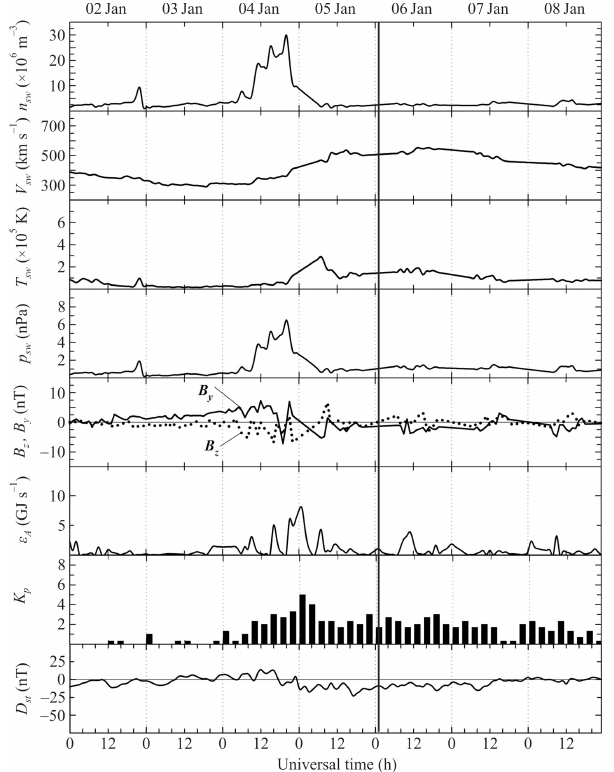
Figure 1. Universal time dependencies of the solar wind parame- ters: observed proton number density ( n sw ), plasma speed ( V sw ), and temperature ( T sw ); calculated dynamic pressure ( p sw ); mea- sured components of the interplanetary magnetic field ( B z and B y ); estimated energy input ( ε A ) into the Earth’s magnetosphere from the solar wind per unit time; and Kp- and Dst-indices for the 2– 8 January 2019 period. Dates are shown along the upper abscissa axis. Experimental data are retrieved from https://omniweb.gsfc.